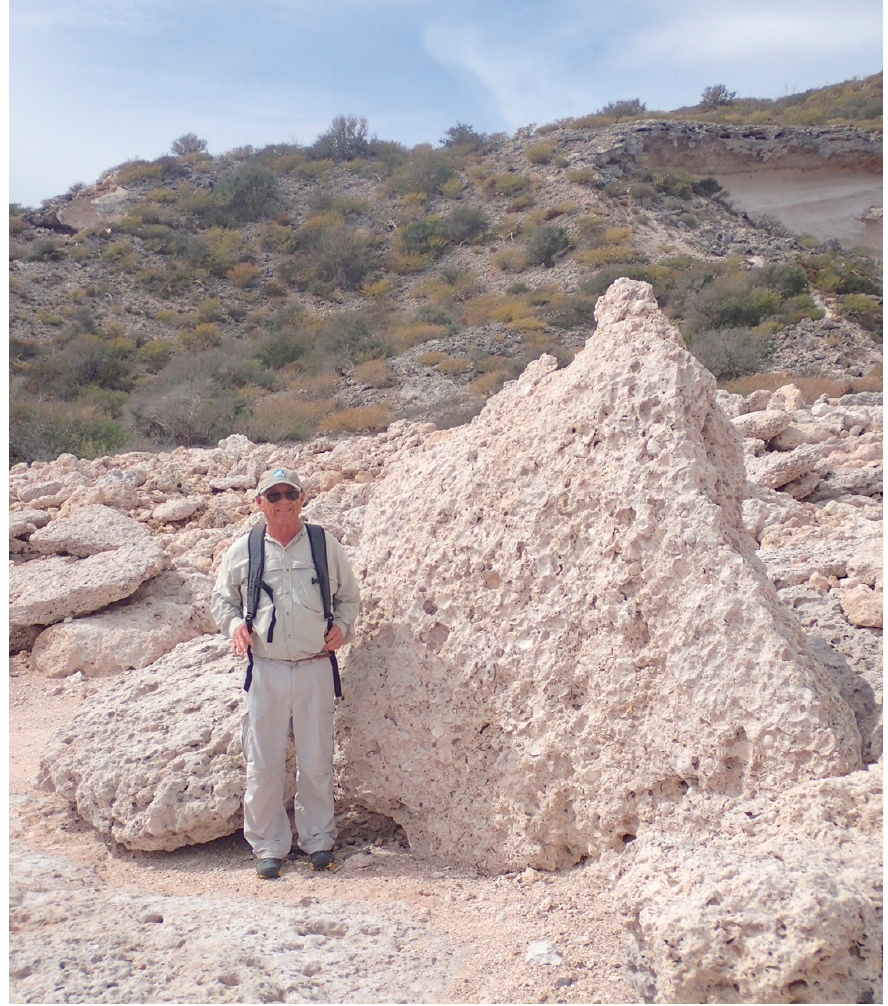
Figure 4. Another, but thicker block of Pliocene limestone that sits tilted on edge further back from the rim of the 12-m terrace at Arroyo Blanco. Extensive fossil bivalves with shells dominantly convex downward match the adjacent surface from which it was peeled away.